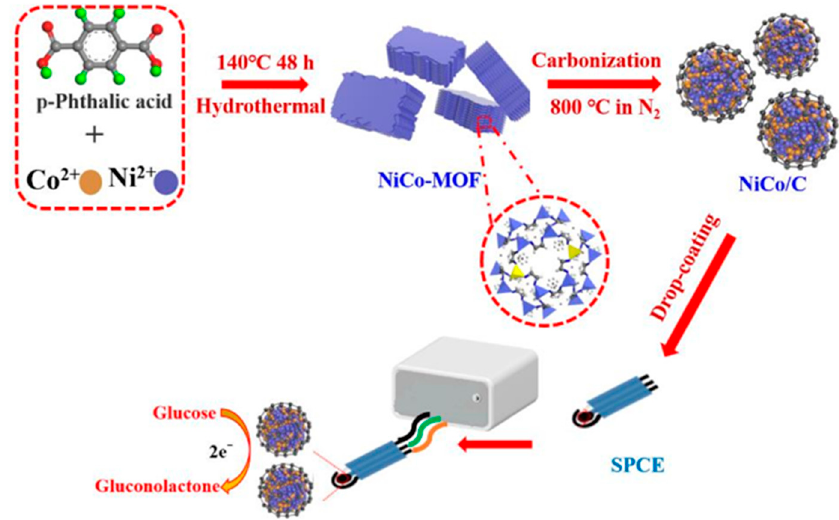
Figure 11. Scheme of the preparation process of the NiCo/C − based assay for glucose determination [101]. Copyright: John Wiley and Sons.